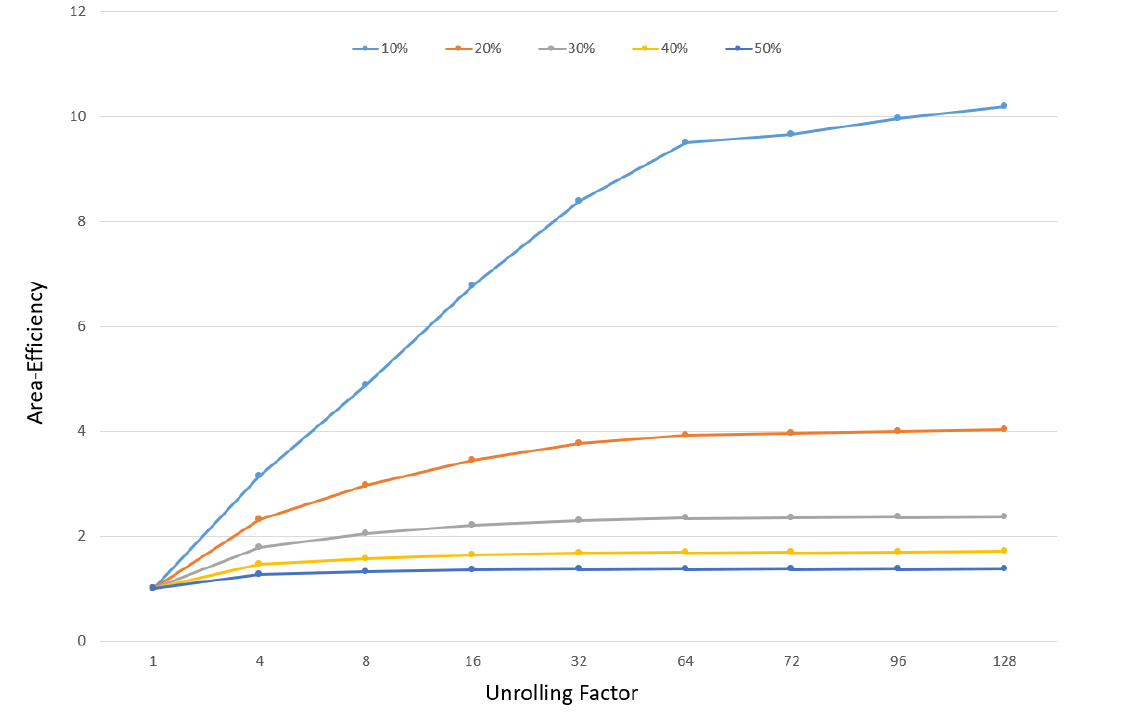
Figure 7. Area-efficiency vs. unrolling factor for different C